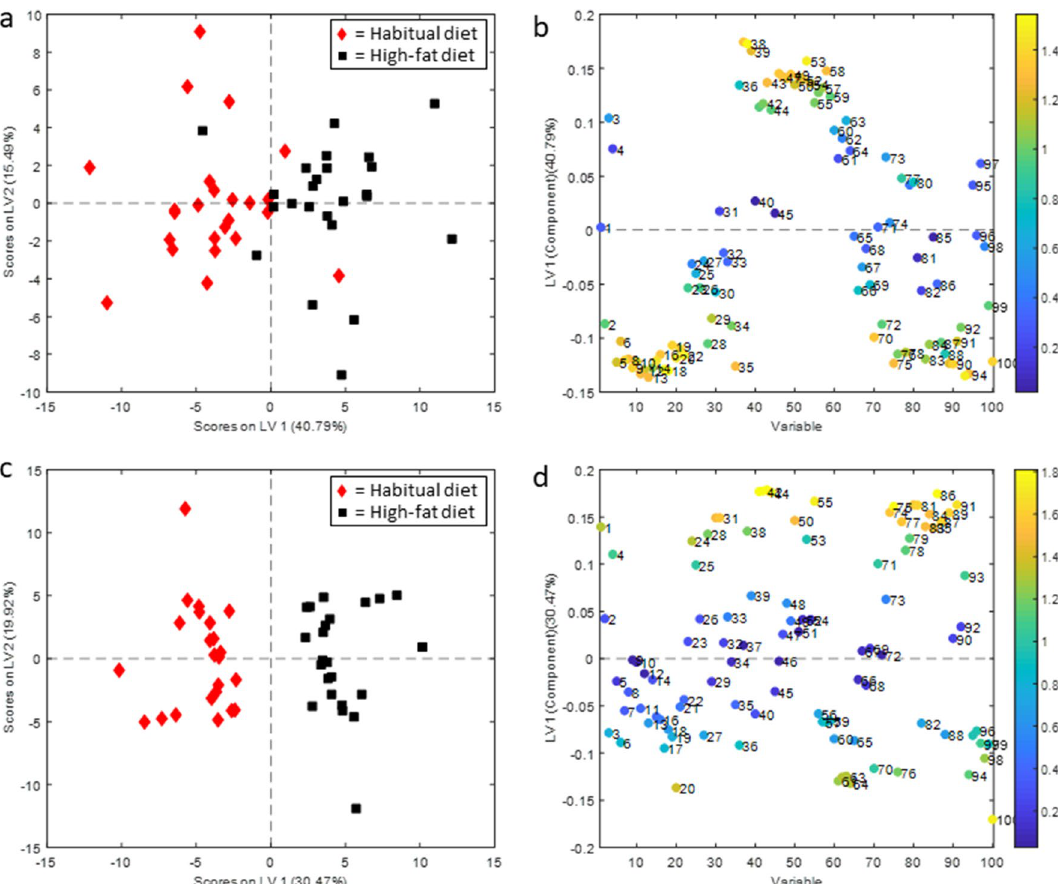
Figure 2. Scores and loading plots from multilevel partial least squares discriminant analyses for discriminating lipoprotein profiles at baseline (habitual diet) from those after 5 days of high-fat diet. ( a, b ) in fasted samples ( c, d ) in postprandial samples. LV = latent variable, A1 = apolipoprotein A1, A2 = apolipoprotein A2, AB = apolipoprotein B100, CH = cholesterol, TG = triglycerides, VLDL = very-low-density lipoprotein, FC = free cholesterol, PL = phospholipids, IDL = intermediate-density lipoprotein, LDL = low-density lipoprotein, HDL = High-density lipoprotein. 1: Total Serum A1, 2: Total Serum A2, 3: Total Serum AB, 4: Total Serum